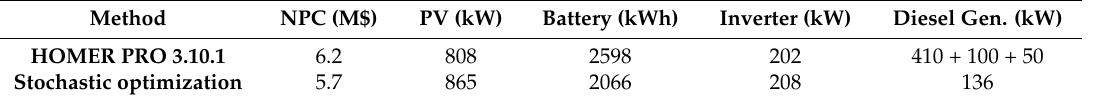
Table 5. Optimal size of the system with the probabilistic method described in